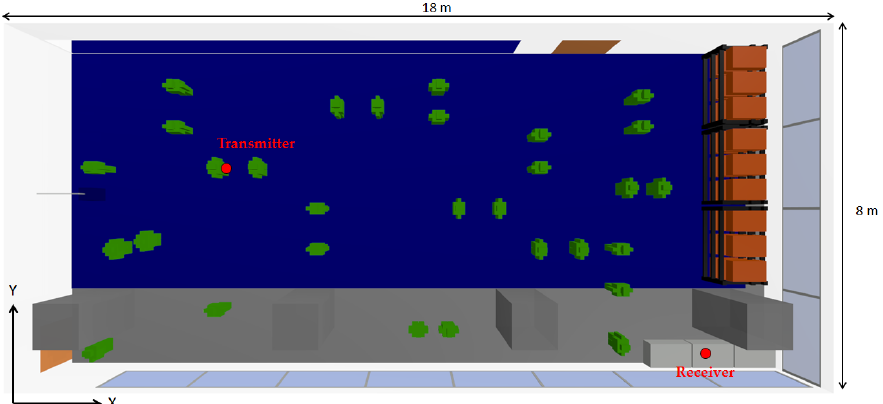
Figure 6. Upper view of the scenario presented in Figure 3 with the position of the transmitter element and the linear distances where the measurements have been taken (white dashed lines).